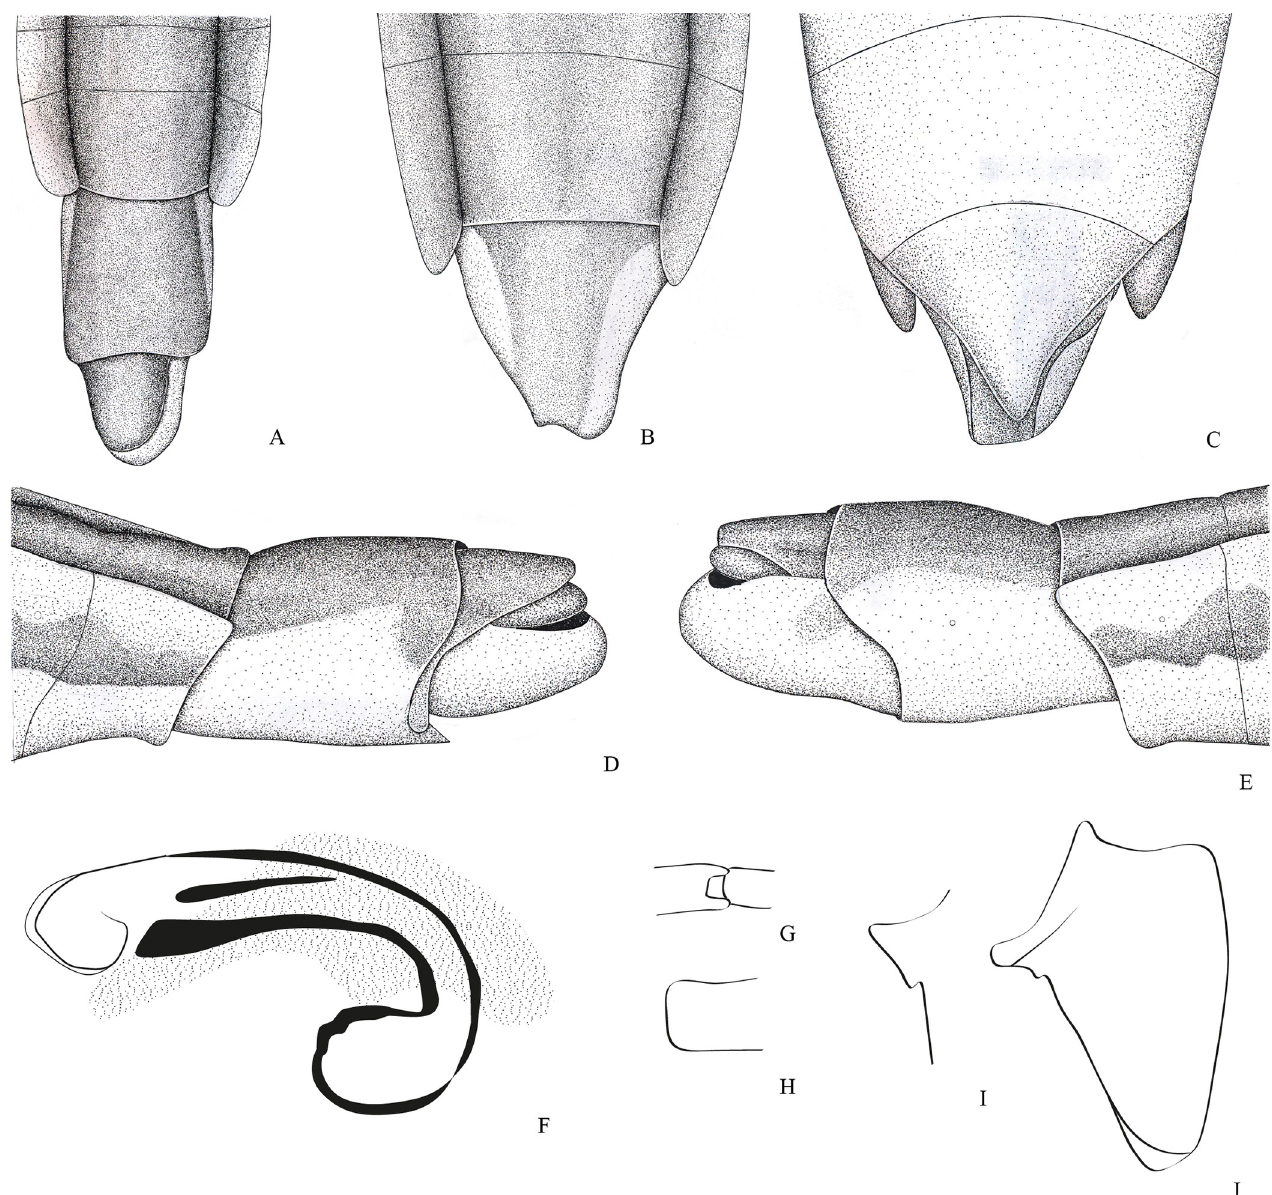
Fig 10. Potamobates unidentatus . (A) Male, terminalia, dorsal view; (B) female, terminalia, dorsal view; (C) female, terminalia, ventral view; (D) male, terminalia, left lateral view; (E) male, terminalia, right lateral view; (F) phallus, lateral view; (G) junction between dorsal and ventral sclerite; (H) base of ventral sclerite; (I) proctiger, left basolateral process; (J) proctiger, dorsal view. 5 – Male pygophore and proctiger sinistrally rotated about 30˚ (Fig 25A and 25C); female abdominal tergum VIII about twice as long as mediotergite VII, with lateral margins abruptly converging on posterior 2/3 and not curved ventrally (Fig 25M); ratio between projection of female abdominal sternum VII and total length of sternum VII 0.7:1.0 . . . P . manzanoae 5 ’–Male pygophore and proctiger sinistrally rotated about 20˚ (Fig 10A); female abdominal tergum VIII subequal in length to mediotergite VII, with lateral margins uniformly converging posteriorly and curved ventrally (Fig 10B); ratio between projection of female abdominal ster- num VII and total length of sternum VII 0.5:1.0 (Fig 10C) . . . P . unidentatus